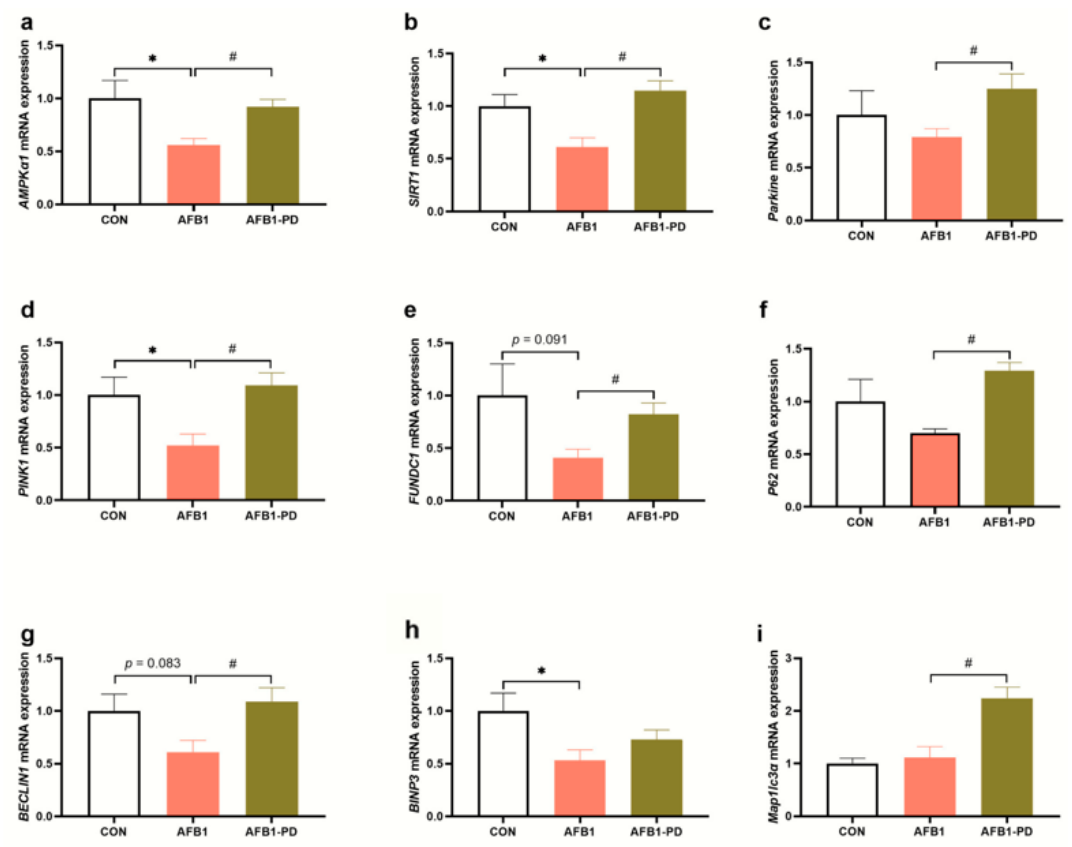
Figure 4. Polydatin (PD) improves hepatic mitophagy in aflatoxin B1 (AFB1) mice. ( a – i ) The mRNA expression of protein kinase AMP-activated catalytic subunit alpha 1 ( AMPK α 1 ), sirtuin 1 ( SIRT1 ), Parkin , PTEN-induced putative kinase 1 ( PINK1 ), FUN14 domain-containing 1 ( FUNDC1 ), P62 , BECLIN1 , BCL2/adenovirus E1B 19 kDa protein-interacting protein 3 ( BINP3 ), microtubule-associated protein 1 light chain 3 alpha ( Map1lc3a ). CON, mice are given 0.5% dimethyl sulfoxide; AFB1, mice are given 300 µ g AFB1/kg body weight/day; AFB1-PD, mice are given 100 mg PD/kg body weight/day and then exposed to AFB1. Results are represented as mean and standard error (n = 5). * p < 0.05 when compared with the CON group, # p < 0.05 when compared with the AFB1